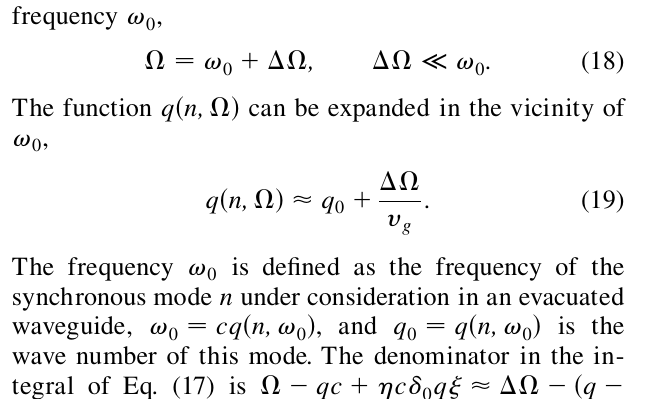
FIG. 1. Dimensionless growth rate Im x as a function of the dimensional detuning y . The maximum of Im x is reached